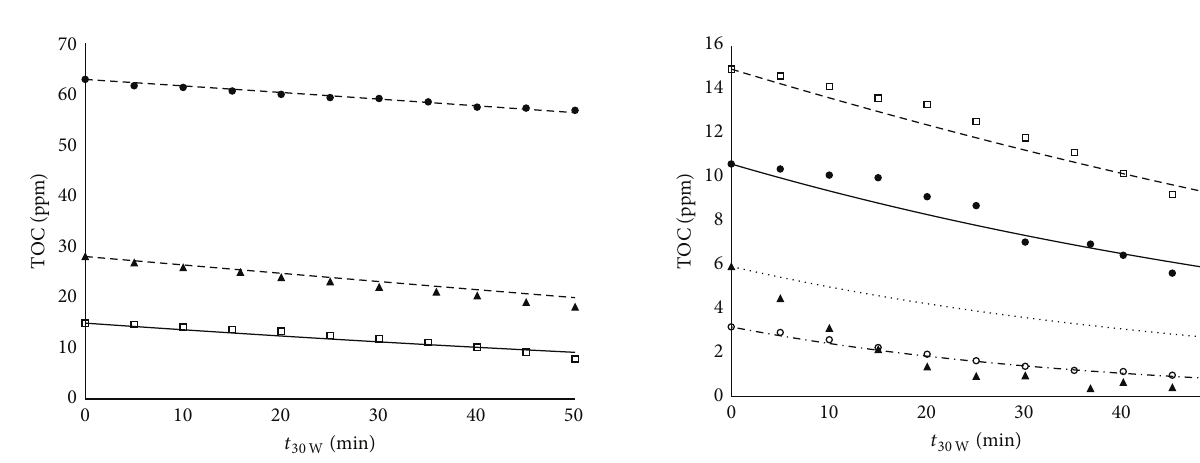
Figure 6: Solar mineralization of binary mixtures at 30 ppm.